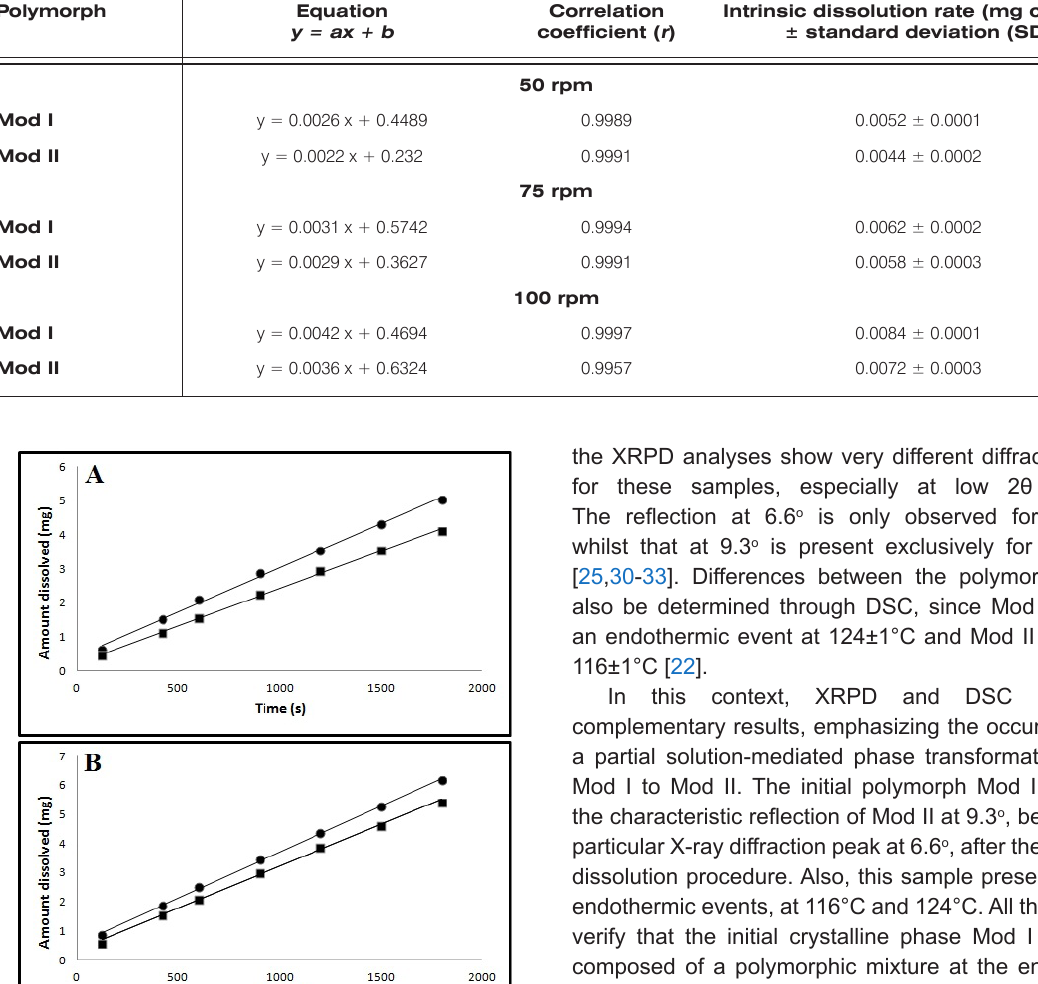
Table 1. Data respective to the intrinsic dissolution of polymorphs Mod I and Mod II, under distinct speed rotations.